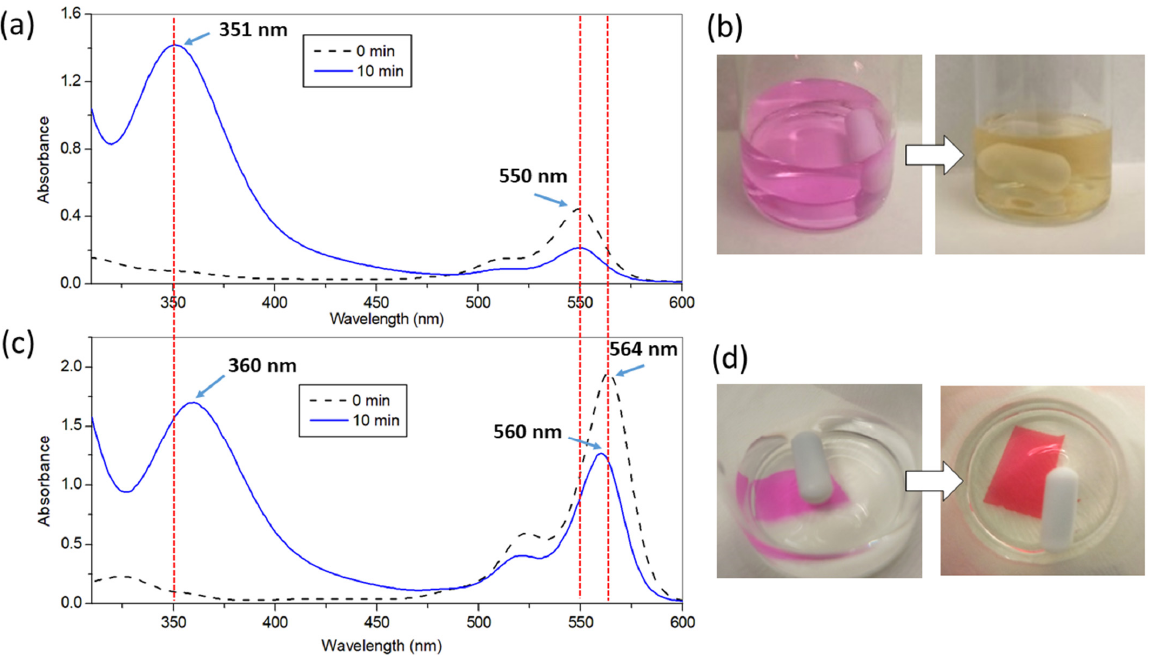
Figure 9. ( a ) UV-vis absorption spectra of a solution of RB (5 µM) and KI (0.1 M) before (dashed line) and after irradiation for 10 min (continuous line); ( b ) Visual aspect of the solution indicated in ( a ) at time 0 and after 48 min of irradiation; ( c ) UV-vis absorption spectra of an A4 film immersed in KI solution (0.1 M) before (dashed line) and after irradiation for 10 min (continuous line); ( d ) Visual aspect of the solution and polymer indicated in ( c ) at time 0 and after 35 min of irradiation.